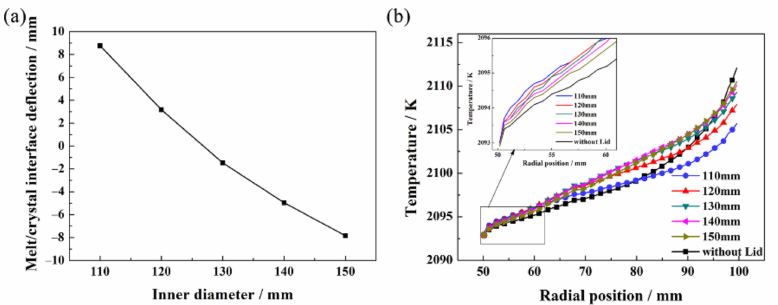
Figure 6. The curve of ( a ) the melt/crystal interface deflection and ( b ) radial temperature distributions versus inner diameter D in of the insulation lid from 110 mm to 150 mm. The inset is an enlarged portion near the triple